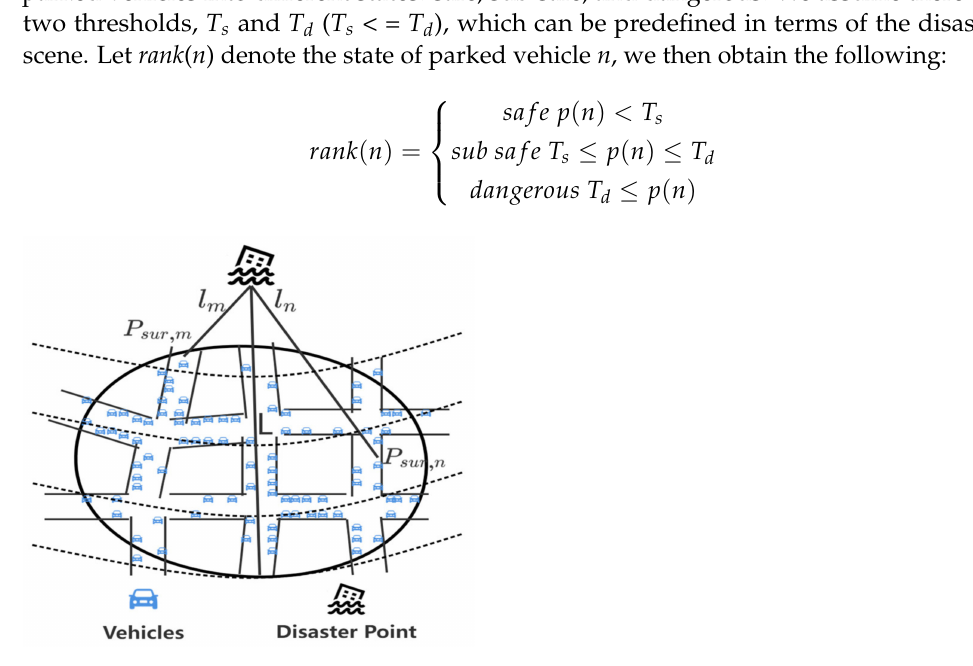
Figure 2. Disaster